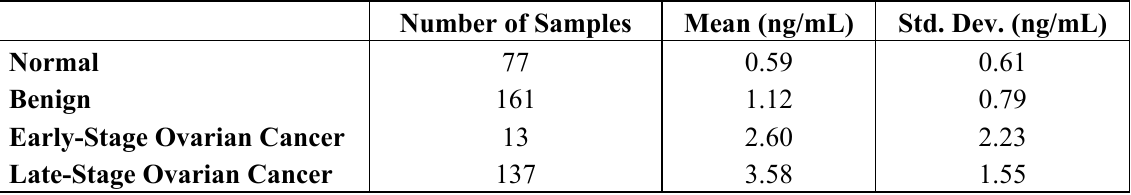
Table 1. Elevated urinary Bcl-2 in cohorts for healthy controls, benign diseases, and early- and late-stage ovarian cancer (N:388)